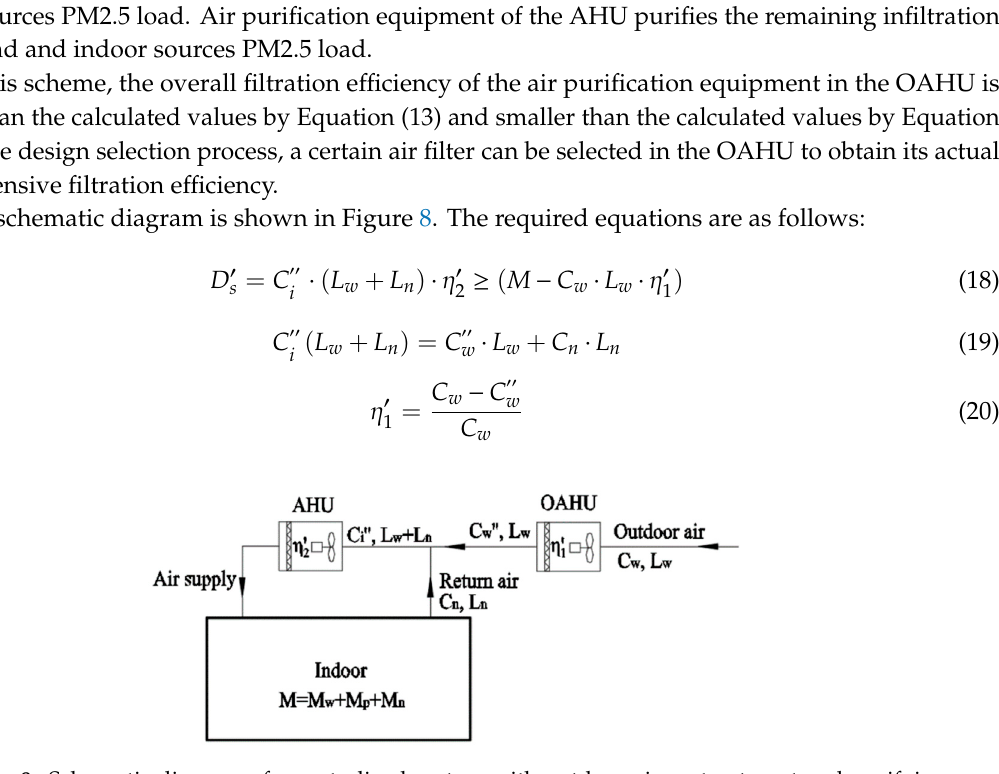
Figure 8. Schematic diagram of a centralized system with outdoor air pretreatment and purifying outdoor air PM2.5 load, partially, infiltrated PM2.5 load and indoor sources PM2.5 load.